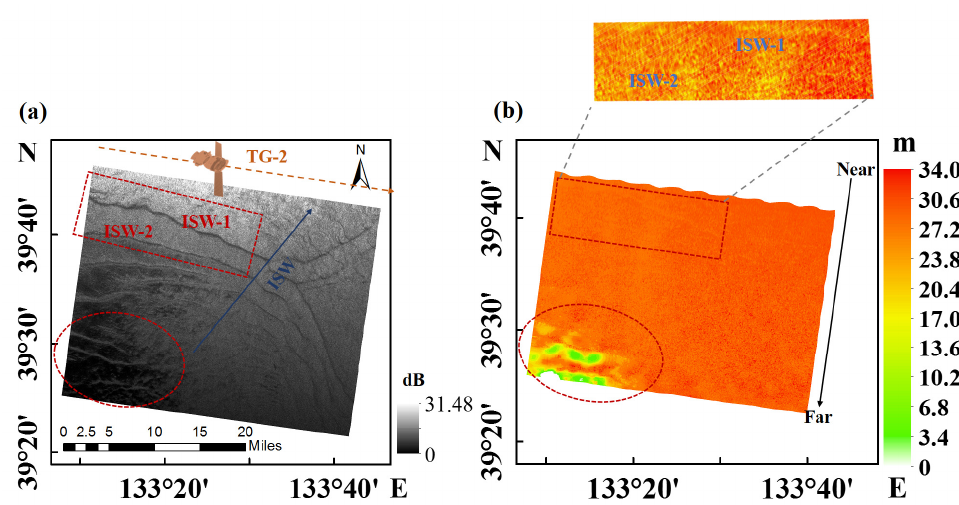
Figure 7. The InIRA images featuring ISWs acquired in the Sea of Japan on 23 September 2016: ( a ) L2 image, the blue solid lines signify the propagation direction of ISWs, while the yellow dashed lines show the flight direction of Tiangong-2; ( b ) L4 image, ISWs features are in the red box, and the red circle is the abnormal